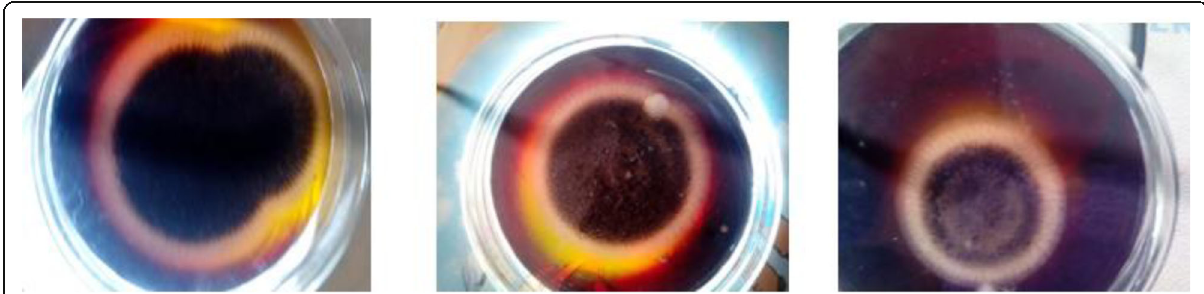
Fig. 5 Citric acid production by different strains of Aspergillus niger on bromocresol green Czapek-Dox agar showing yellow